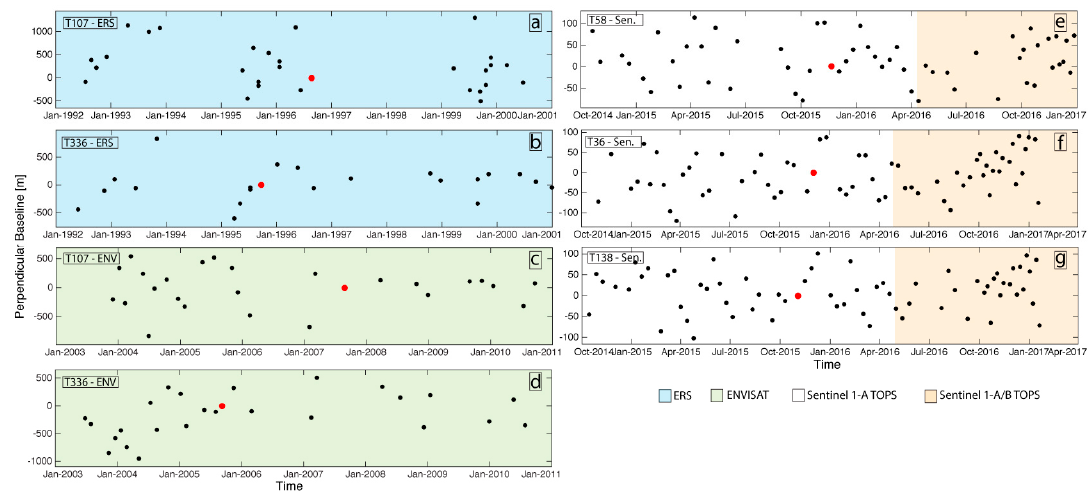
Figure 3. Baseline versus time plots for the seven tracks used in this study. The red dots indicate the master image used as a reference for each track. For the Sentinel data, the period when the two satellites 1A/1B were operational is indicated in orange (before this period, only satellite 1A was operational). Table 1. Characteristics of each processed track.